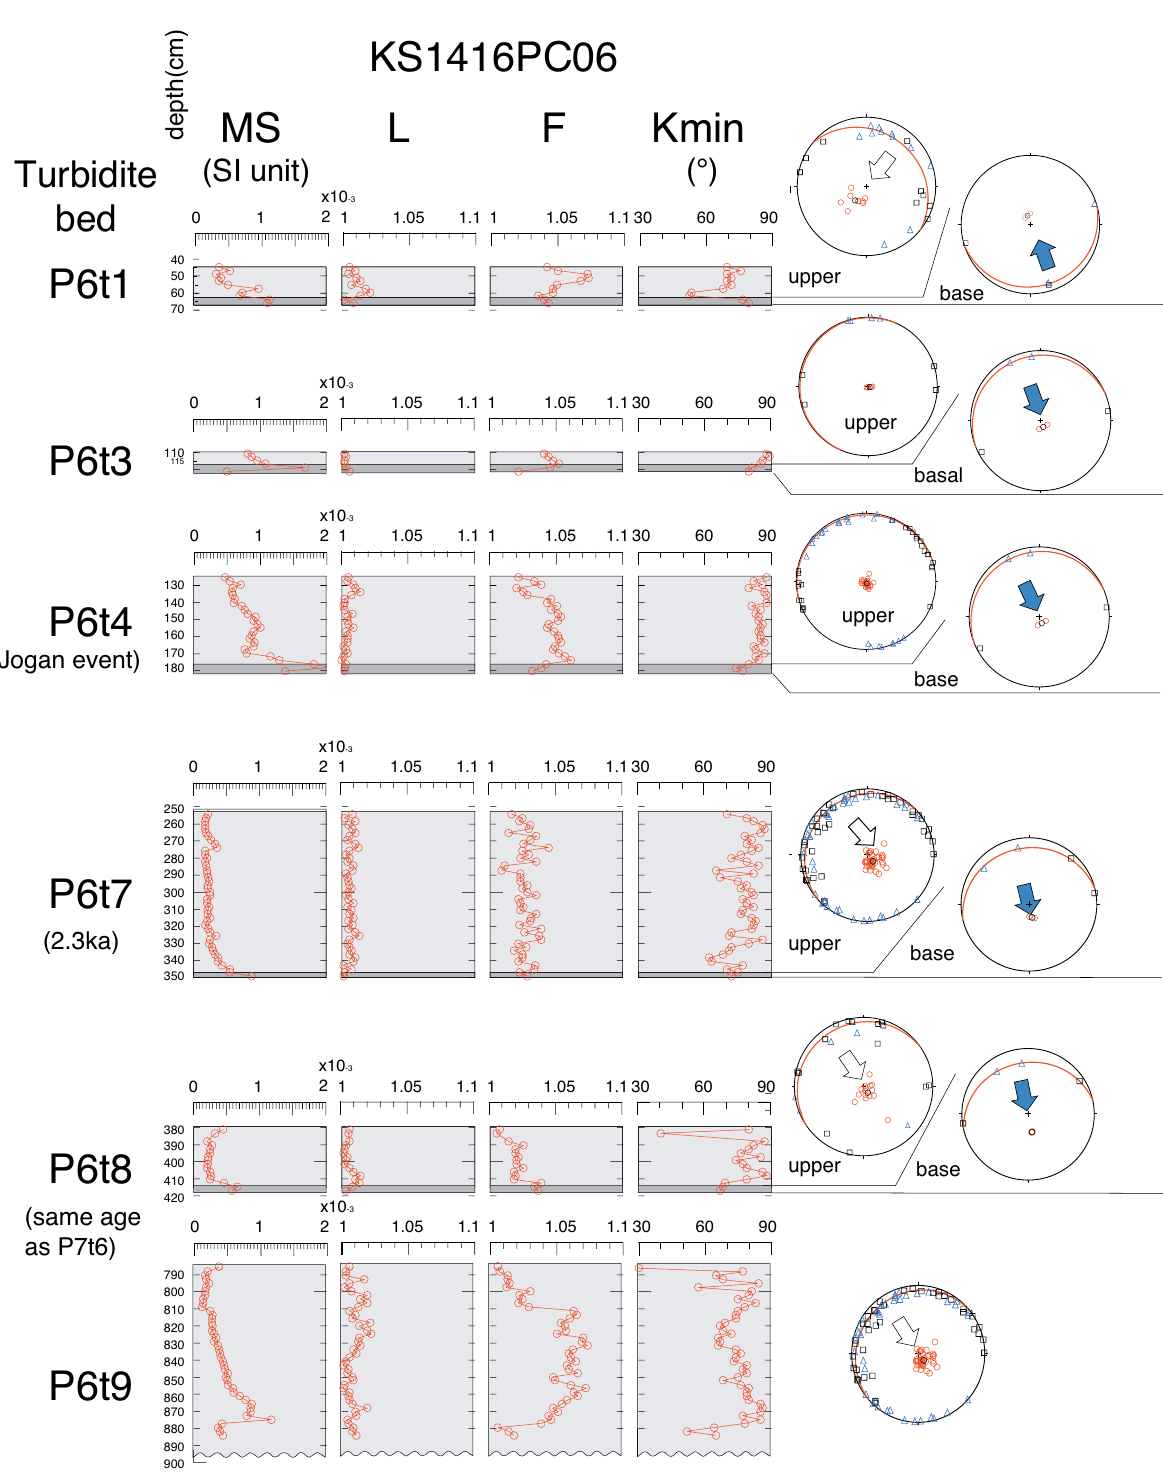
Fig. 9 AMS data of core KS1416PC06. Magnetic susceptibility (MS), “L” and “F” and Kmin inclinations of each turbidite beds and stereo plots of with inferred paleo flow. Blue filed arrows, basal sandy interval; white arrow, upper muddy interval; orange arrows, possible shearing, shorting, or rolling directions. Great circle perpendicular to the Kmin is drawn in red